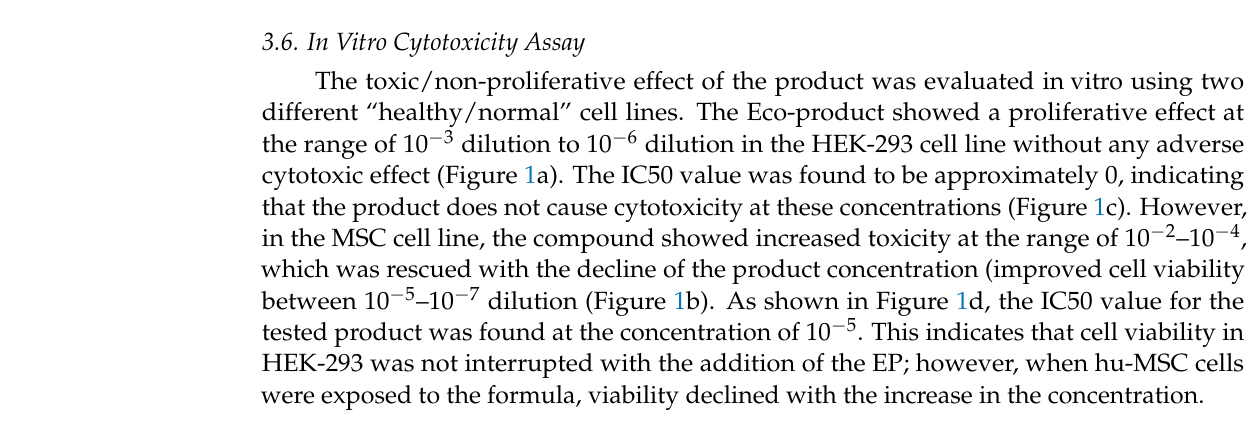
Figure 1. Cell cytotoxicity assessment and dose-response curve. ( a ) Assessment of cell viability in HEK-293 cell line (normalized data). The Eco-product shows a proliferative effect at the range of 10 − 3 dilution to 10 − 6 dilution (incubation period 2, 4, and 7 days) and a non-toxic profile. ( b ) Assess- ment of cell viability in a hu-MSCs cell line (normalized data). The Eco-product shows reduced cell viability between dilution range 10 − 2 –10 − 5 and a rescued proliferative effect at the range of 10 − 6 –10 − 7 dilution (incubation period 2, 4, and 7 days). Results are expressed as mean ± standard deviation (SD), and statistical significance was considered when p < 0.05. ( c ) Dose-response curve of HEK-293 treated with EP for 2, 4, and 7 days. The concentrations range between 10 − 3 and 10 − 6 , and ( d ) Dose- response curve of hu-MSC cells with concentrations ranging between 10 − 2 and 10 − 7 . Results are ex- pressed in percentage of control, and they show the mean of IC50 values ± SD (concentration re- quired to inhibit cell growth by 50%). Data represent the means of two independent experiments, with each concentration tested in triplicate. 3.7. Acute Oral Toxicity Oral feeding of the EP formula at various doses did not cause any mortality, or gross behavioral changes, either immediately or during the 5-week observation period. All re- flexes, food intake, and body weights (with triplicate measurement) were normal and sim- ilar to that of the vehicle-treated group (see Figure 2a). Vital signs were recorded using the MouseOx ® Plus (Starr Life Sciences Corp., Oakmont, PA, USA), which is a non-inva- sive pulse oximeter providing real-time and continuous measurements via a thigh sensor.